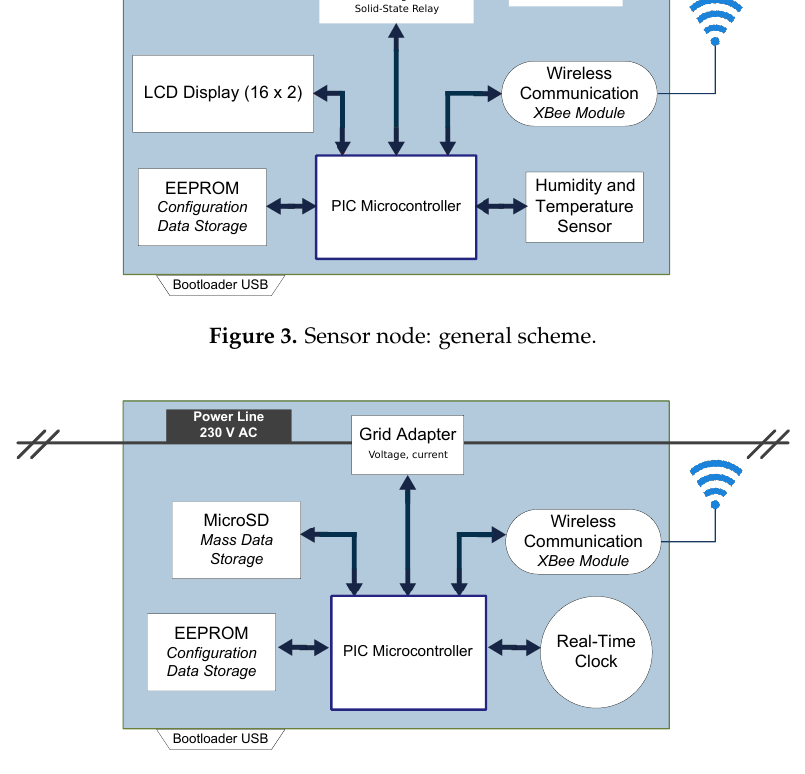
Figure 4. Sink node: general